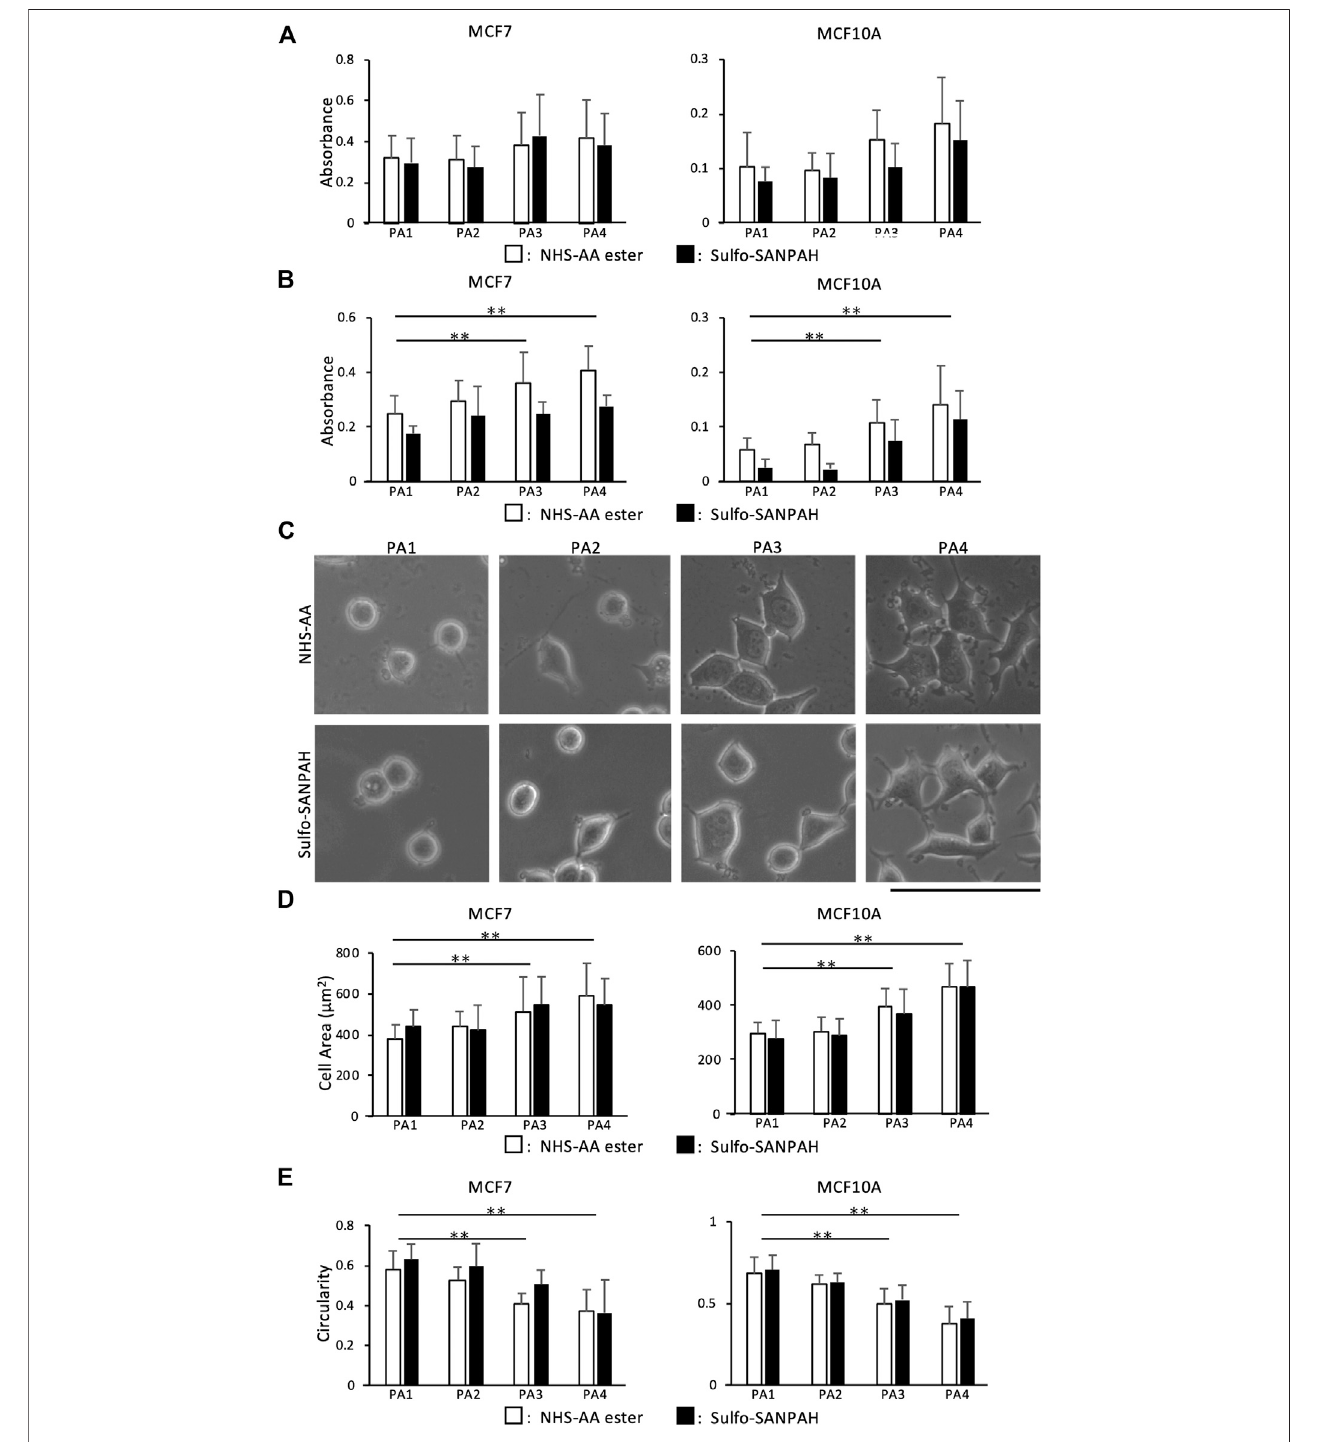
FIGURE 5 | Comparison of cell adhesion, proliferation, and morphology on PA gels containing NHS-AA ester and sulfo-SANPAH. (A) Cell adhesion of MCF7 (left) and MCF10A (right) cells showed no difference on gels of different stiffness containing NHS-AA ester (white) and sulfo-SANPAH (black) (B) The proliferation rate of MCF7 (left) and MCF10A (right) cells was higher on NHS-AA ester gels (white) than on sulfo-SANPAH gels (black), irrespective of stiffness. The proliferation increased onstiffergels (C) NodifferenceinMCF7cellmorphologywasobservedbetweenthetwogelsatanystiffness.Scalebar:100 µm. (D – E) Cellarea (D) andcircularity (E) of MCF7 (left) and MCF10A (right) cells showed no difference on gels of different stiffness containing NHS-AA ester (white) and sulfo-SANPAH (black). The morphology of both cells changed from circular to spreading with increased stiffness. Values represent the mean of three independent replicates ± the SD. ** p < 0.01, * p <